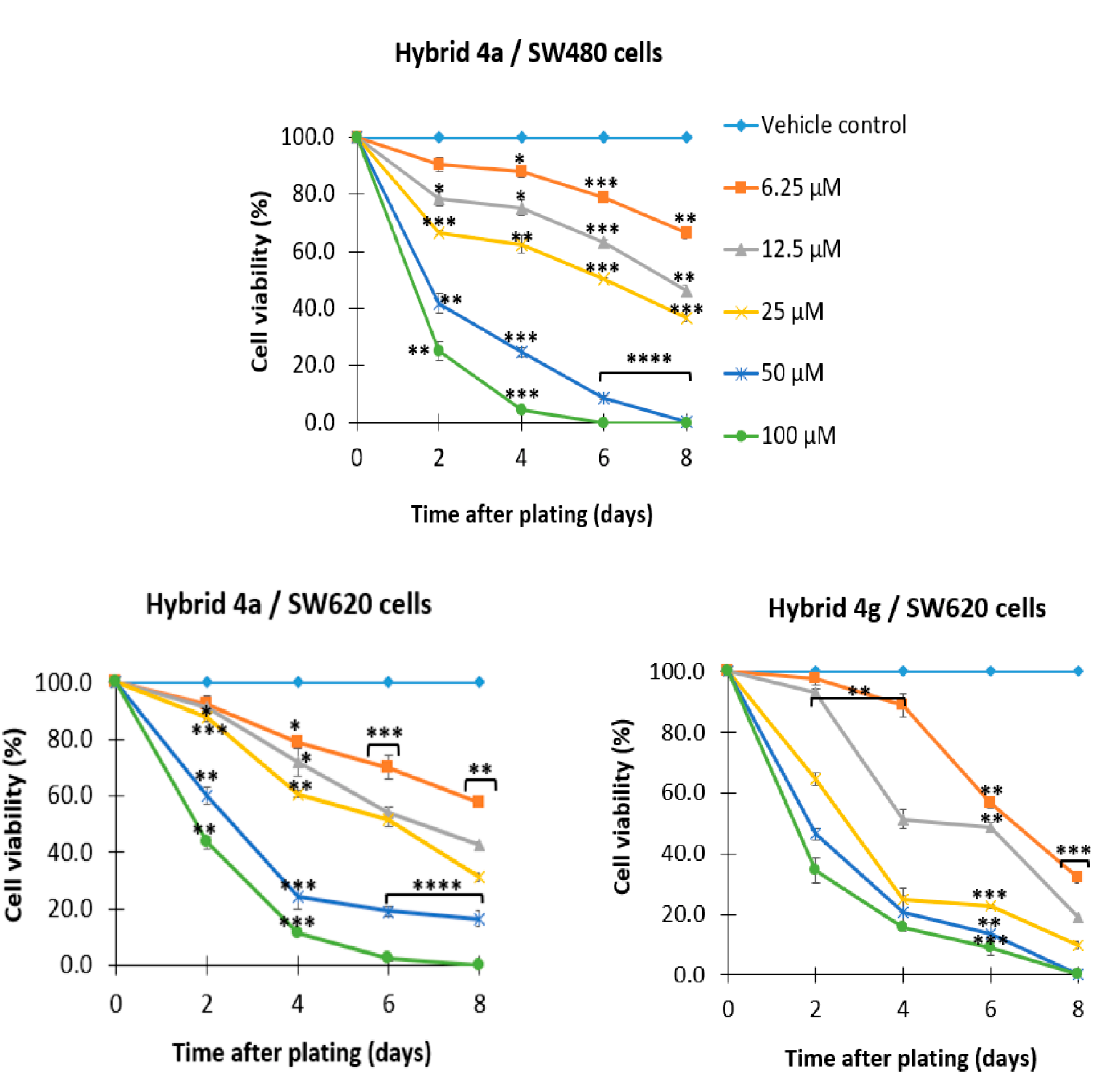
Figure 3. Antiproliferative activity of hybrids 4a and 4g in SW480 and SW620 cells. Data are pre- sented as the mean ± SE of three independent experiments. (* p < 0.05; ** p < 0.01; *** p < 0.001; **** p <